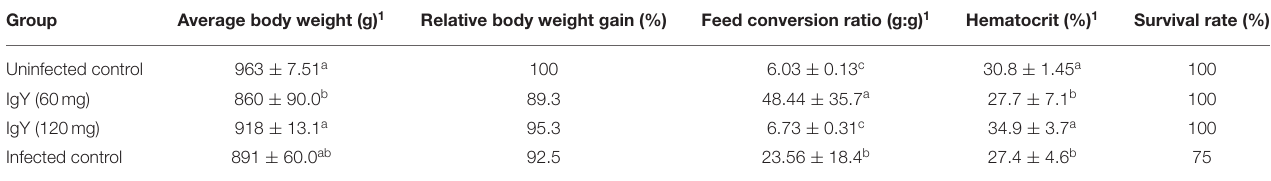
TABLE 2 | Parameters of protection at 7 days post-infection with a crowded dose of E. tenella to SPF White Leghorn chickens supplemented with Eimeria sp.-specific IgYs during the prepatent period. Group Average body weight (g) 1 Relative body weight gain (%) Feed conversion ratio (g:g) 1 Hematocrit (%) 1 Survival rate (%) Uninfected control 963 ± 7.51